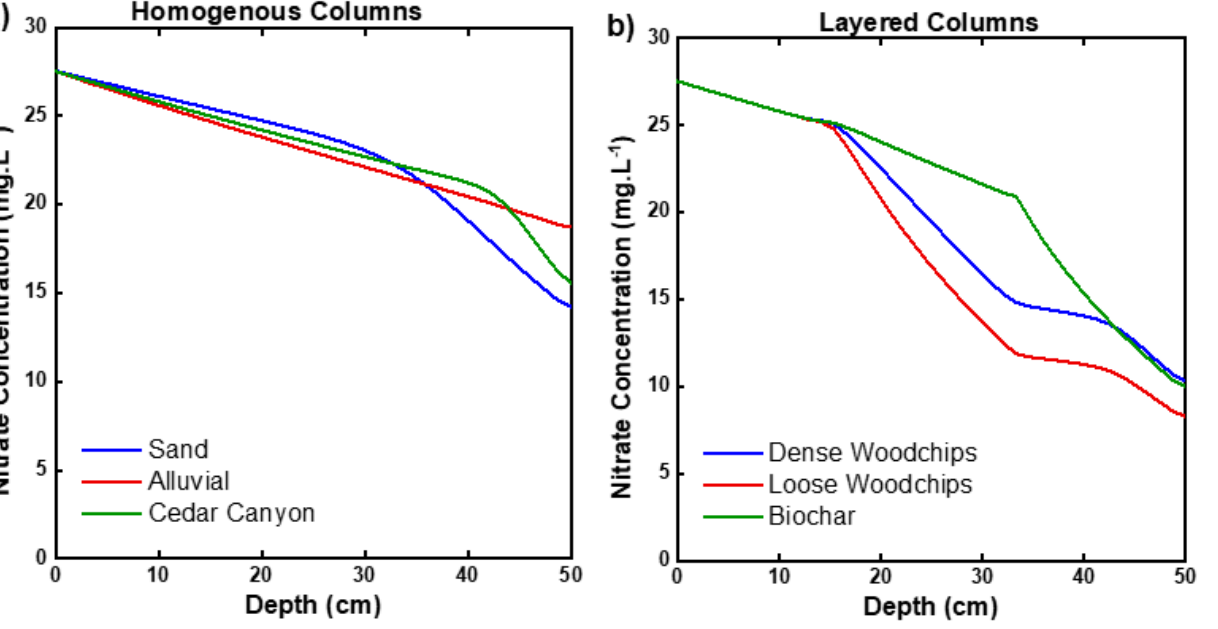
Figure 5. Vertical Nitrate Distribution in ( a ) homogeneous columns (Sand, Alluvial, and Cedar